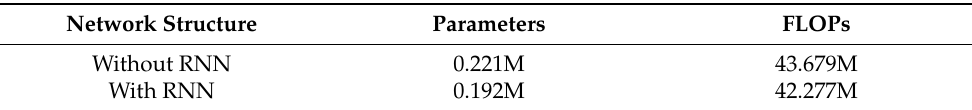
Figure 8. Visualization of detection results with and without RNN. ( a ) Without RNN. ( b ) With RNN. Table 5. Comparison of network parameters and